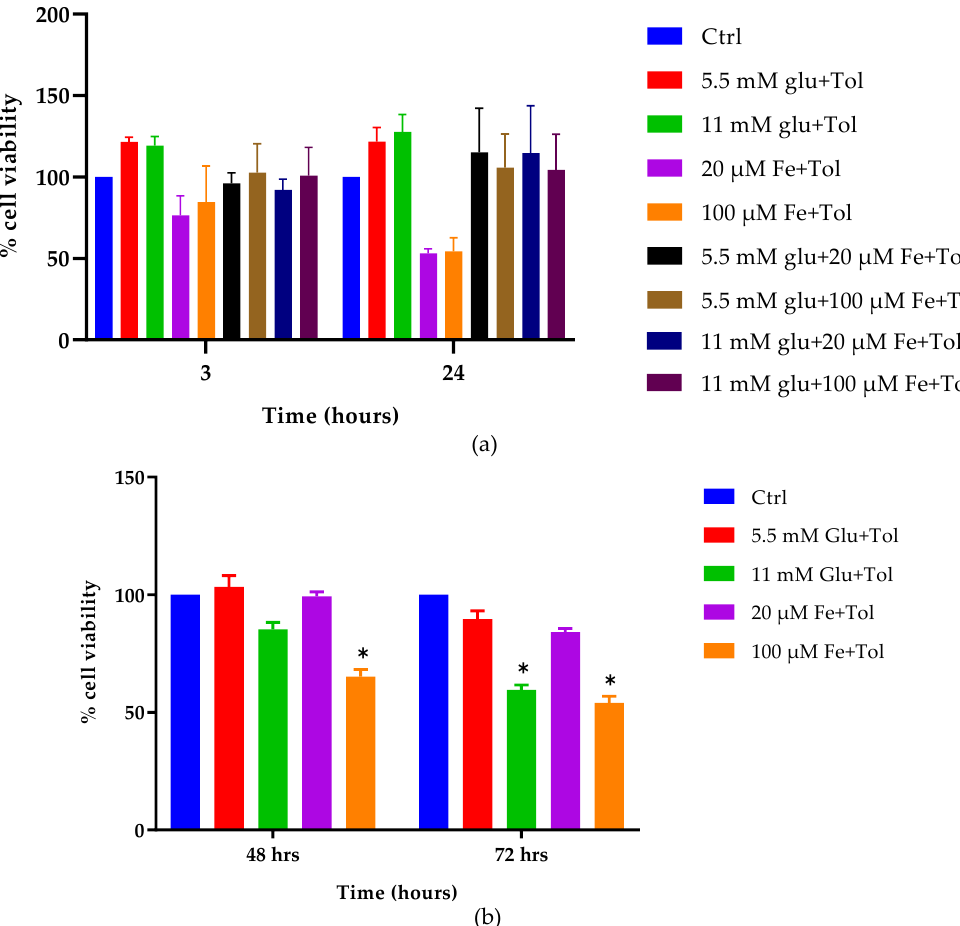
Figure 5. The effect of iron and glucose on MIN6 cell viability. Cytotoxicity assessment was performed by PrestoBlue ® assay at four incubation times [(3 and 24 h ( a ), 48 and 72 h ( b )]. MIN6 cells were exposed to various concentrations of iron (20 μM and 100 μM) and/or glucose (5.5 mM and 11 mM), and combinations of iron and glucose with the addition of tolbutamide as a secretagogue. The data represent mean ± SEM, n = 4. * p < 0.02 represents significance compared to control.